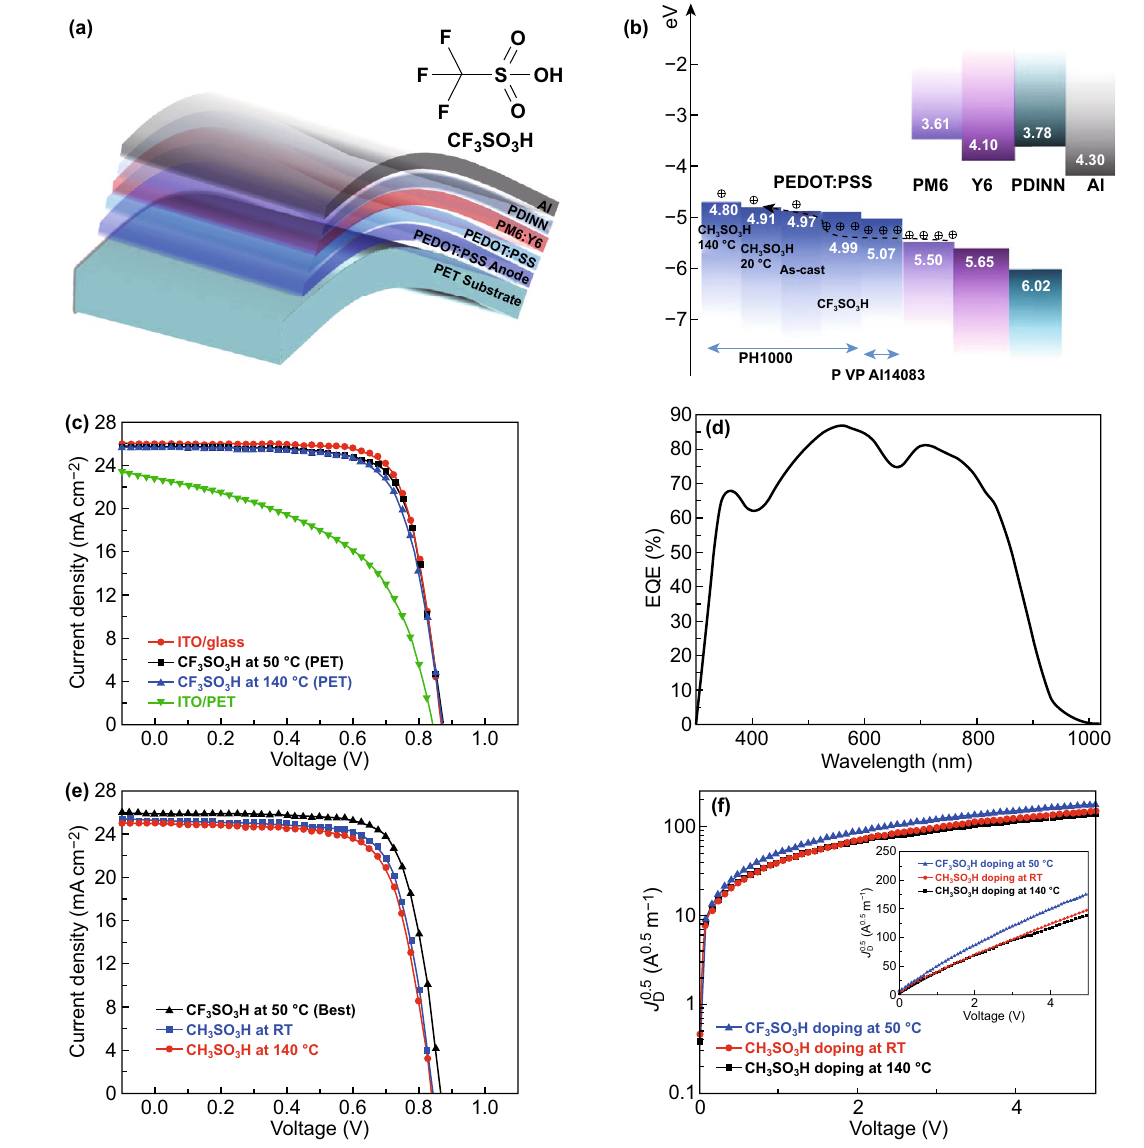
Fig. 4 Flexible OSC characteristics. a Schematic diagrams. b Energy levels. c J – V characteristics of flexible OSCs with PEDOT:PSS and ITO anodes, and the OSCs fabricated on ITO/glass substrates. d EQE of flexible OSCs based on the PEDOT:PSS anodes with 0.8 M CF 3 SO 3 H treat- ments at 50 °C. e J – V characteristics of flexible OSCs with the CH 3 SO 3 H-doped anodes, and the best flexible OSC with the CF 3 SO 3 H-doped anodes. f Electric filed dependence of J D0.5 of the hole-only devices based on the anodes with the CF 3 SO 3 H and CH 3 SO 3 H